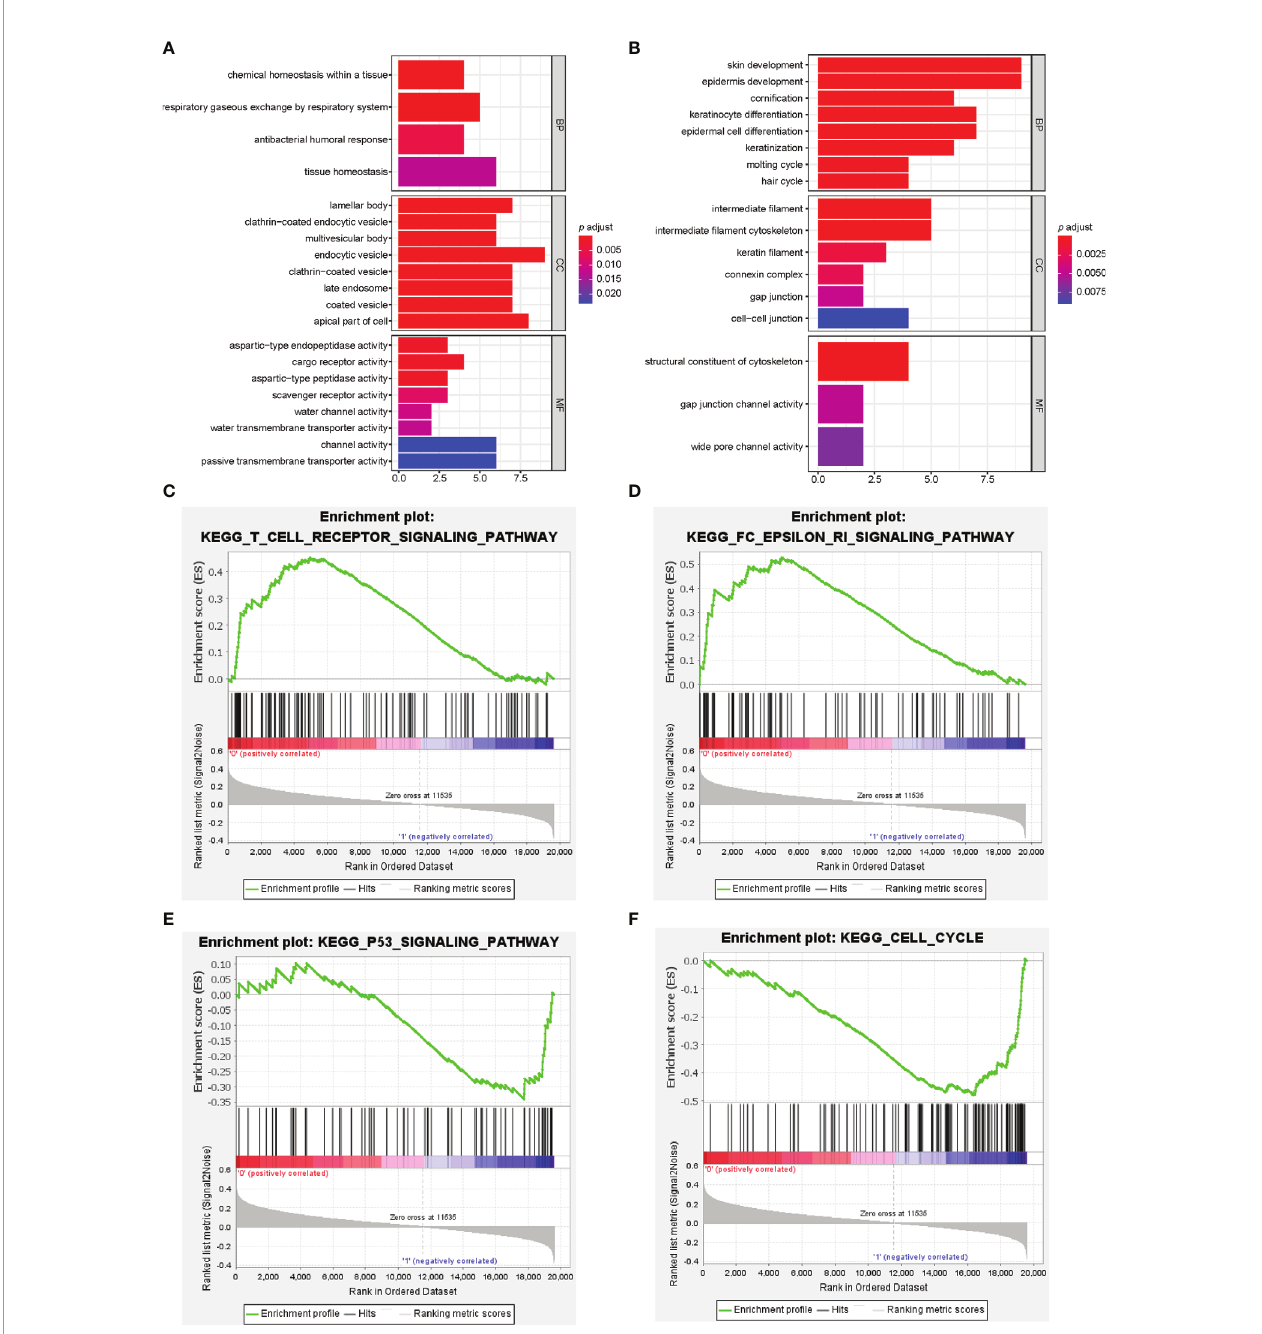
FIGURE 4 | Pathway analysis of immune-related lncRNA model. (A, B) Gene ontology analysis was used to explore the potential functional mechanism of immune- related lncRNA model, and the results are visualized in the low-risk group (A) and high-risk group (B) . Immune-related lncRNA signaling pathway obtained by gene set enrichment analysis, including T cell receptor signaling pathway (C) , Fc epsilon RI pathway (D) , p53 signaling pathway (E) , and cell cycle (F)